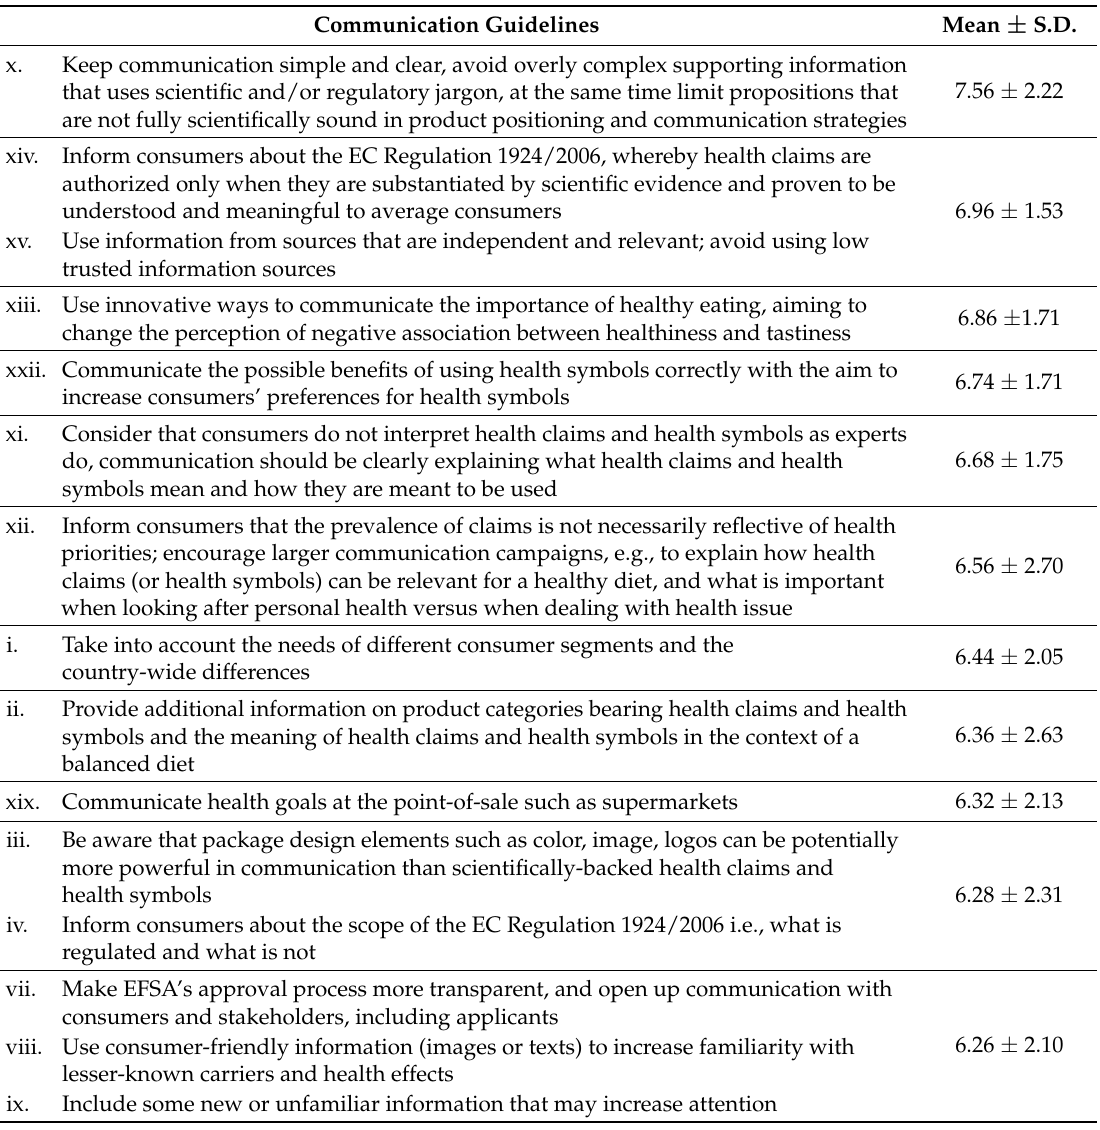
Table 3. Communication guidelines ranked based on the aggregated mean scores from the five criteria of evaluation in descending order ( n =